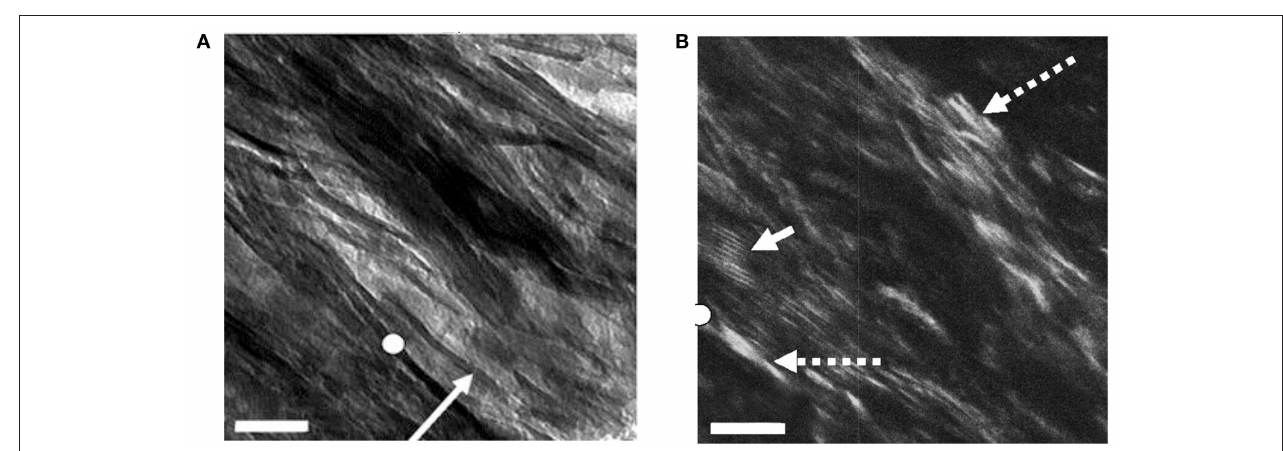
FIGURE 3 | Bright- and dark-field views of same area in an ion-milled section of a bovine femur cut parallel to the long axis of the bone: (A) Bright field: white circle, reference point in both images; arrow, edge-wise view of single mineral lamella; (B) Dark-field image obtained using 002 reflection; dashed arrows, single crystals of apatite; solid arrow, Moiré fringes produced by two overlapping apatite crystals viewed face-on. Scale = 50 nm. From Schwarcz et al. [49]